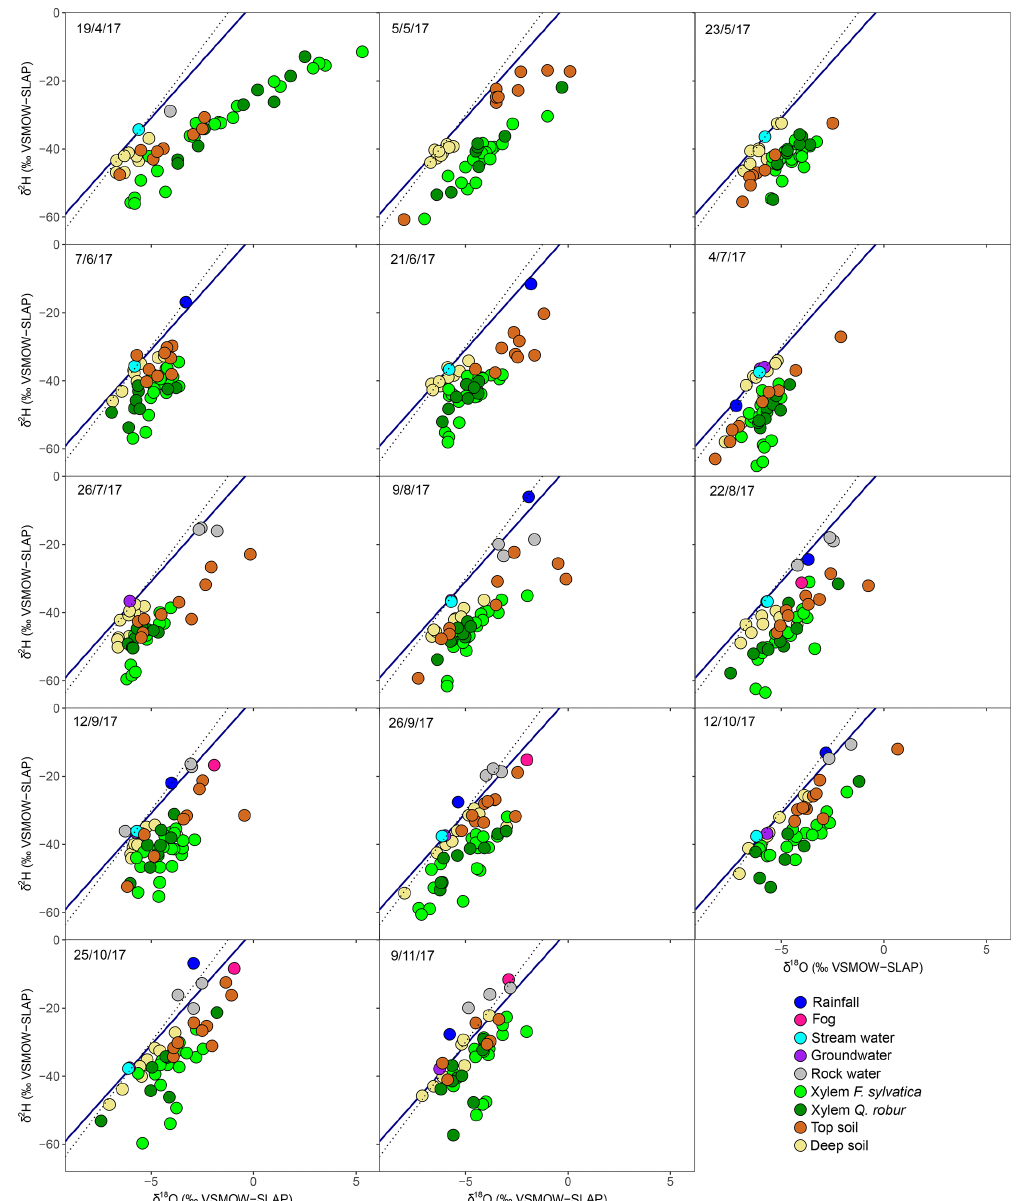
Figure 2. Dual-isotope ( δ 2 H and δ 18 O) plot of xylem water of the two studied species ( F. sylvatica and Q. robur ) and its potential sources (soil water at two depths, groundwater, stream, rain, fog and rock water) for every sampling campaign conducted in 2017. The blue line indicates the LMWL, whereas the dashed black line indicates the global meteoric water line